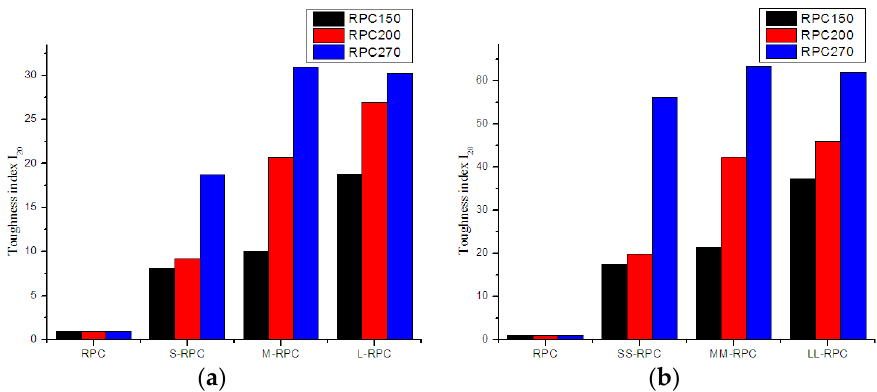
Figure 9. Effects of steel fiber length on the toughness index I 20 of RPC: ( a ) 0.5% fiber content and ( b ) 2.0% fiber content.